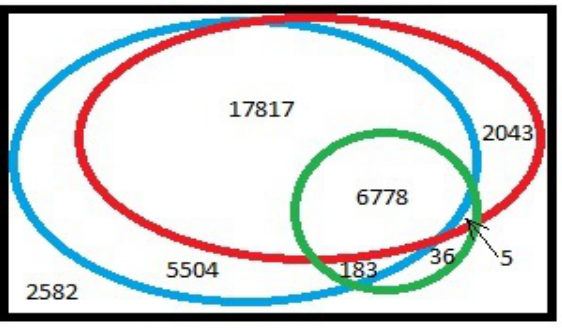
Figure 1. TASTD Voyages by Types of